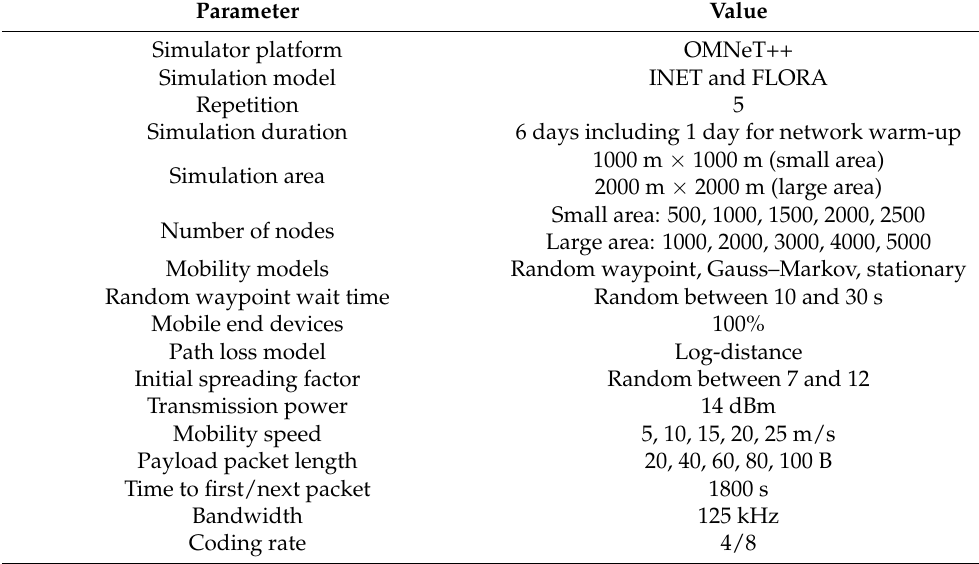
Table 1. Simulation parameters.